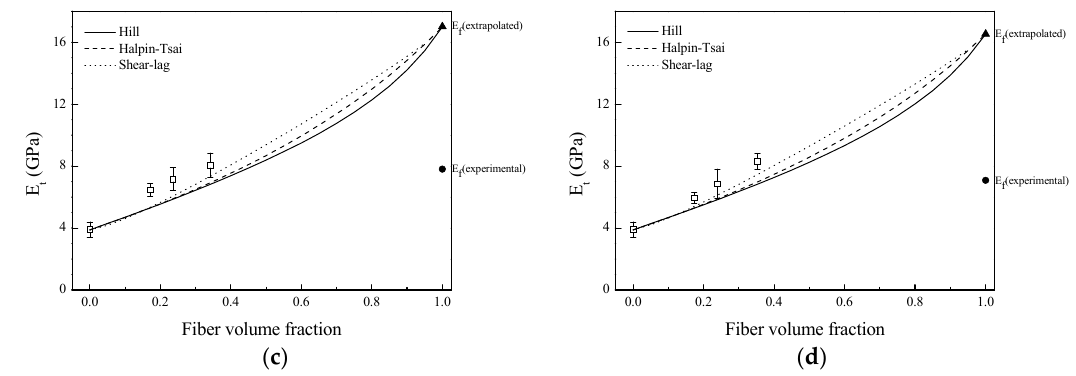
Figure 7. Determination of composite modulus values with extrapolated Young modulus values of untreated and treated sisal fibers: ( a ) untreated; ( b ) silane; ( c ) NaOH; and ( d ) NaOH + silane.